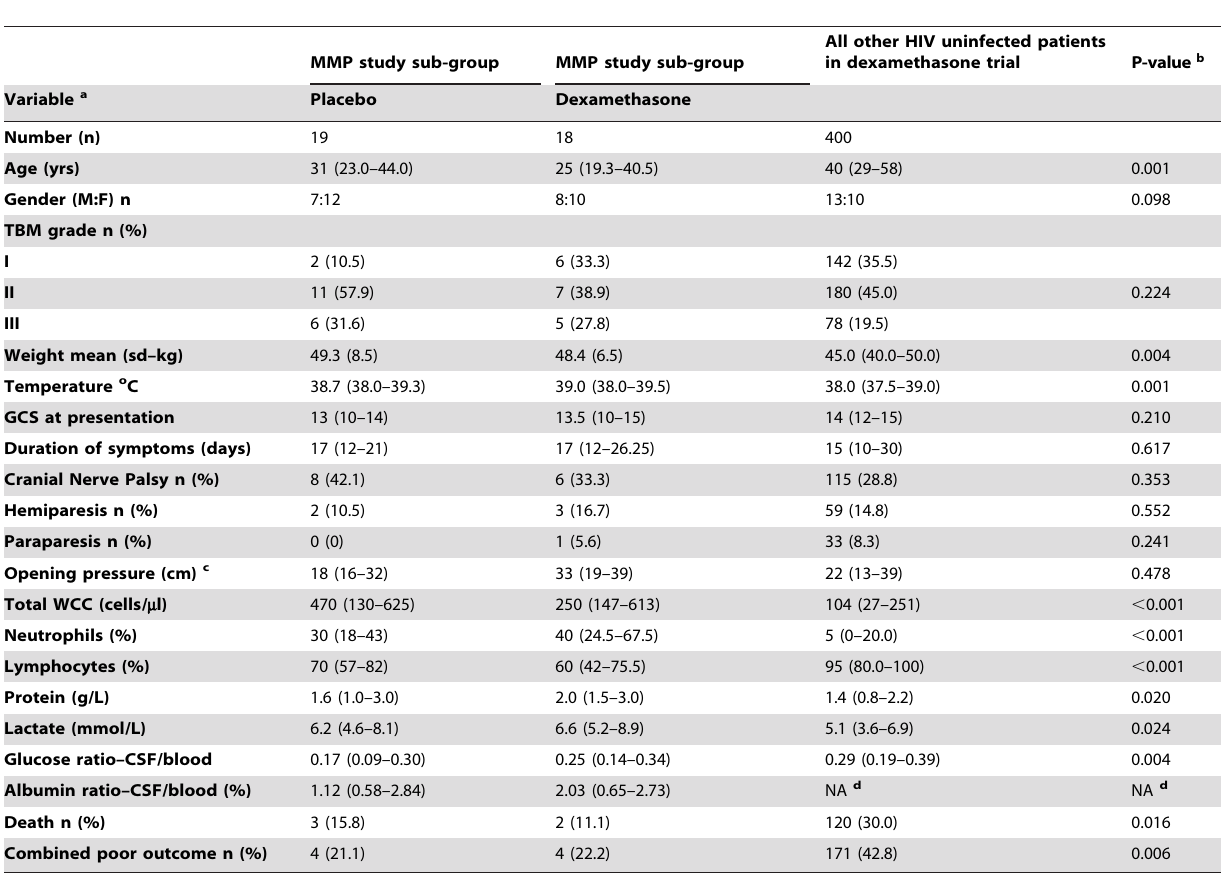
Table 1. Comparison of the baseline clinical features from patients in the study of MMPs with all other HIV uninfected patients recruited to the controlled trial of